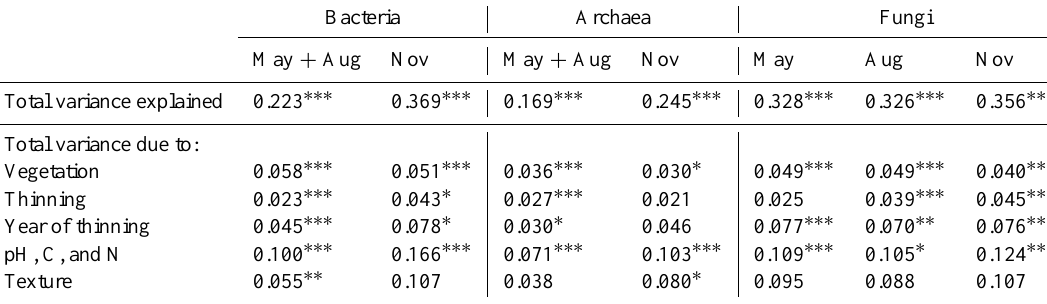
Table 3. Decomposition of variance of TRFLP ordinations.